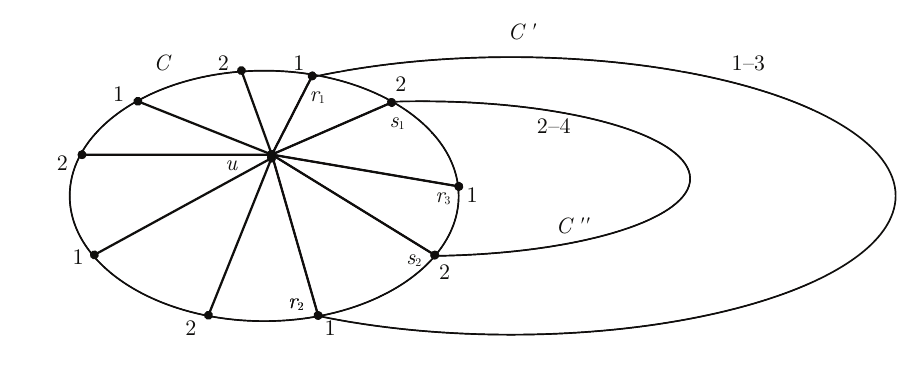
Figure A1. The “telescoping” process used to prove Theorem